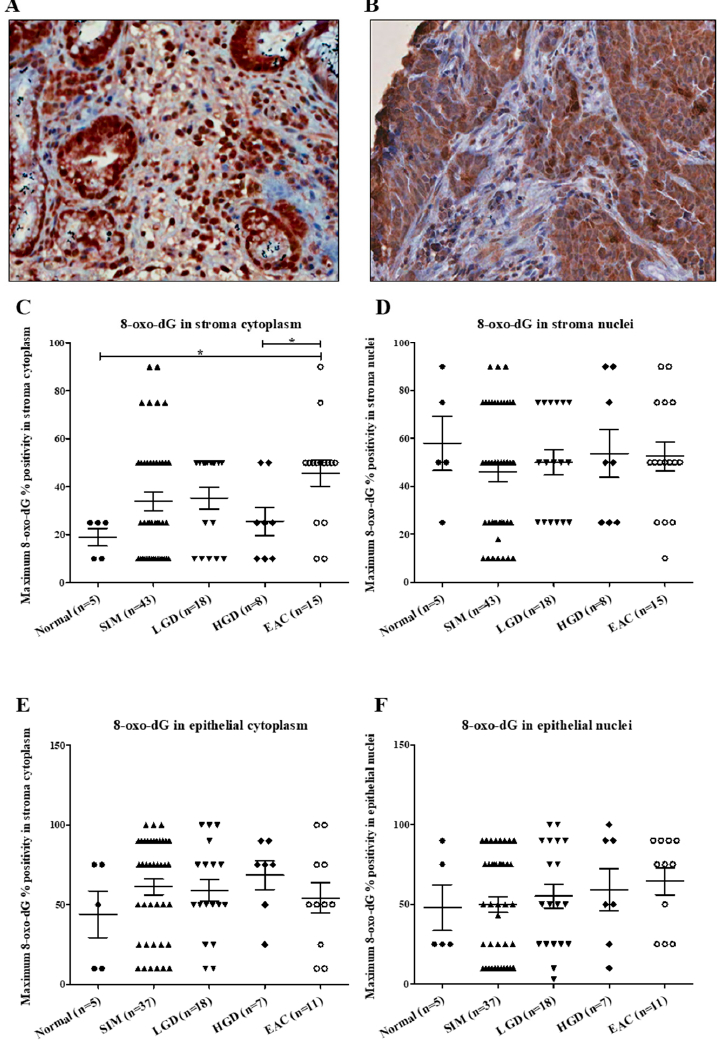
Figure 1. ( A – G ): 8-oxo-dG stroma and epithelial staining in aged-matched histology groups across the Barrett’s esophagus disease spectrum. ( A ) Section of a core of Barrett’s intestinal metaplasia, at magnification 40 × , demonstrating strong nuclear and cytoplasmic 8-oxo-dG staining in 100% of the glandular epithelium. ( B ) Section of a core of esophageal adenocarcinoma, at magnification 40 × , showing moderate cytoplasmic staining in 100% of the epithelium, and weak to moderate cytoplasmic staining in 50% of the stroma cells and no nuclear staining. ( C ) Kruskal–Wallis analysis with Dunn’s multiple-comparison test demonstrated a significant increase in stroma cytoplasm positive for 8-oxo-dG in esophageal adenocarcinoma (EAC) compared with normal and high-grade dysplasia (HGD) patients. No significant di ff erence was seen in 8-oxo-dG positivity in ( D ) stroma nuclei ( p = 0.741), ( E ) epithelial cytoplasm ( p = 0.763) and ( F ) epithelial nuclei ( p = 0.697). * p <